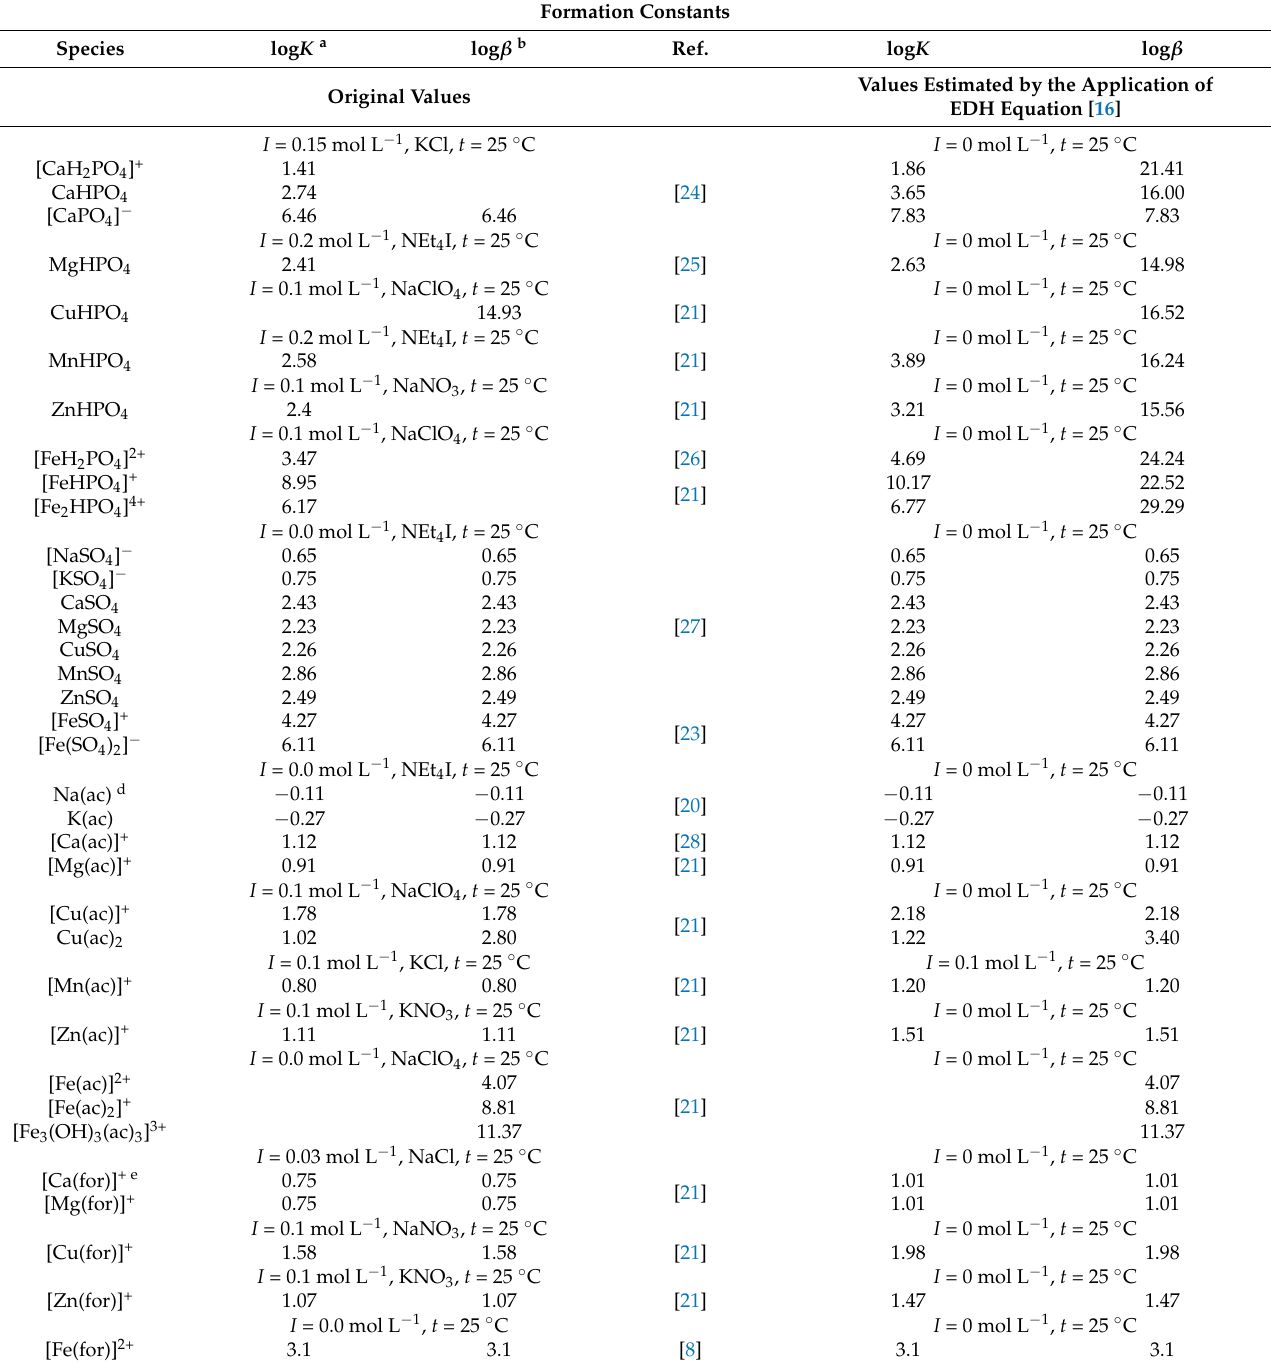
a log K values refer to the general reaction: pM n+ + qH deprotonated ligand; for hydrolytic species the reaction is: pM n+ + qOH − (cid:28) [M p (OH) q ] np − q ; b log β values refer to the general reaction: pM n+ + qL z − + rH + (cid:28) [MpLqHr] np+r − qz ; for hydrolytic species the reaction is: pM n+